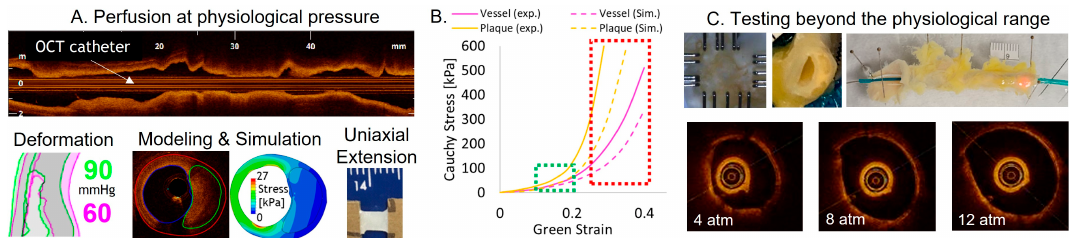
Figure 4. Current approaches to plaque characterization ( A ), results ( B ), and next-generation methods ( C ).